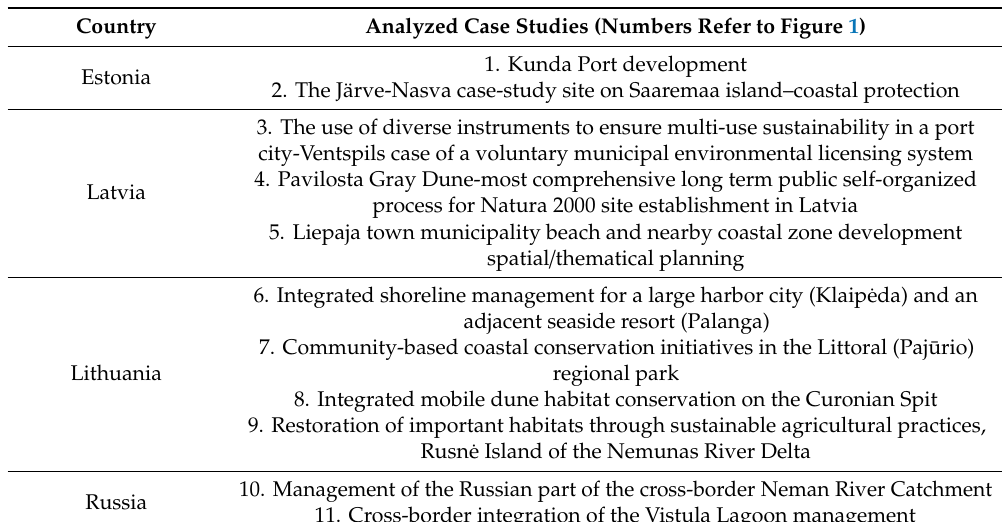
Table 1. Themes of the Eastern Baltic re-analysis studies.